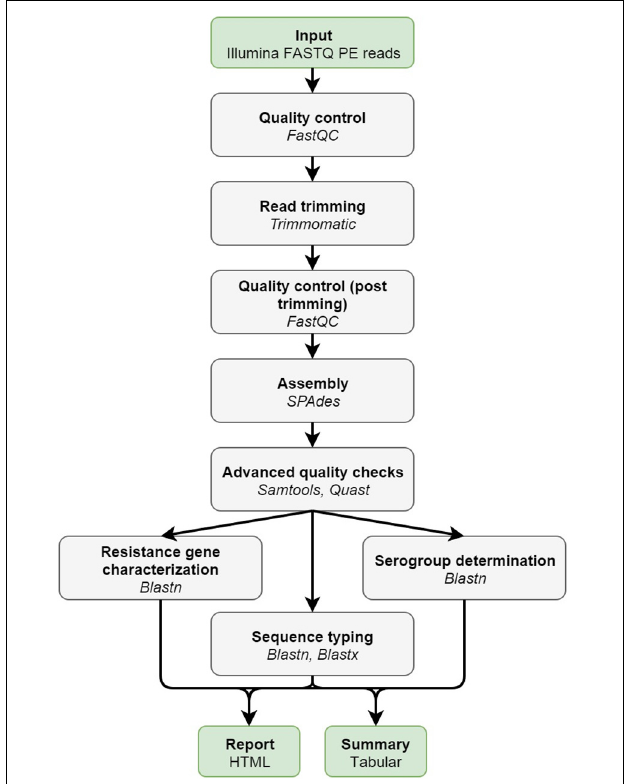
FIGURE 1 | Overview of the bioinformatics workflow. Each box represents a component corresponding to a series of tasks that provide a certain well-defined functionality (indicated in bold). Major bioinformatics utilities employed in each module are also mentioned (indicated in italics). Abbreviations: paired-end